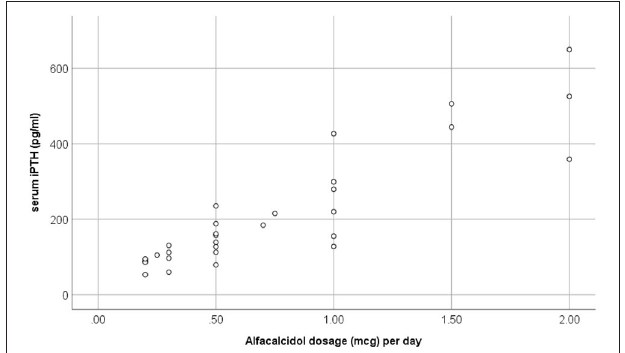
FIGURE 3 | Scatter plot analysis of 6-month mean alfacalcidol dosage (mcg) per day and mean serum intact parathormone (iPTH) in chronic kidney disease (CKD) stage 4–5D patients.